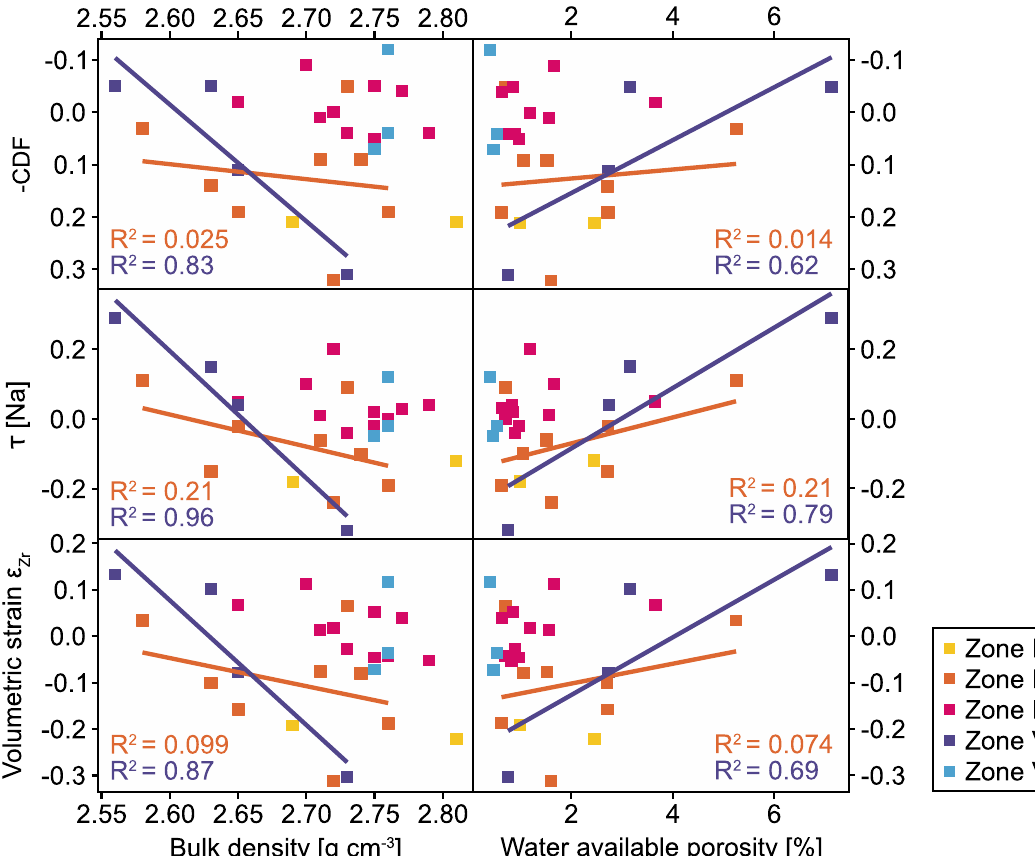
Figure 8. Chemical weathering indicators CDF and τ, and volumetric strain ε Zr versus bulk density and water- available porosity. Chemical loss in the more strongly weathered zones III and V (orange and purple) shows a significant dependance on density and porosity, whereas less weathered (pink) and unweathered (blue) zones IV and VI shows no dependance. Physical weathering indicated by volumetric strain ε Zr shows a dependence on density and porosity but variations in porosity cannot completely traced back to an increase in strain. More coherent and therefore less weathered samples are over-represented because the petrophysical analysis could not be conducted on disintegrated